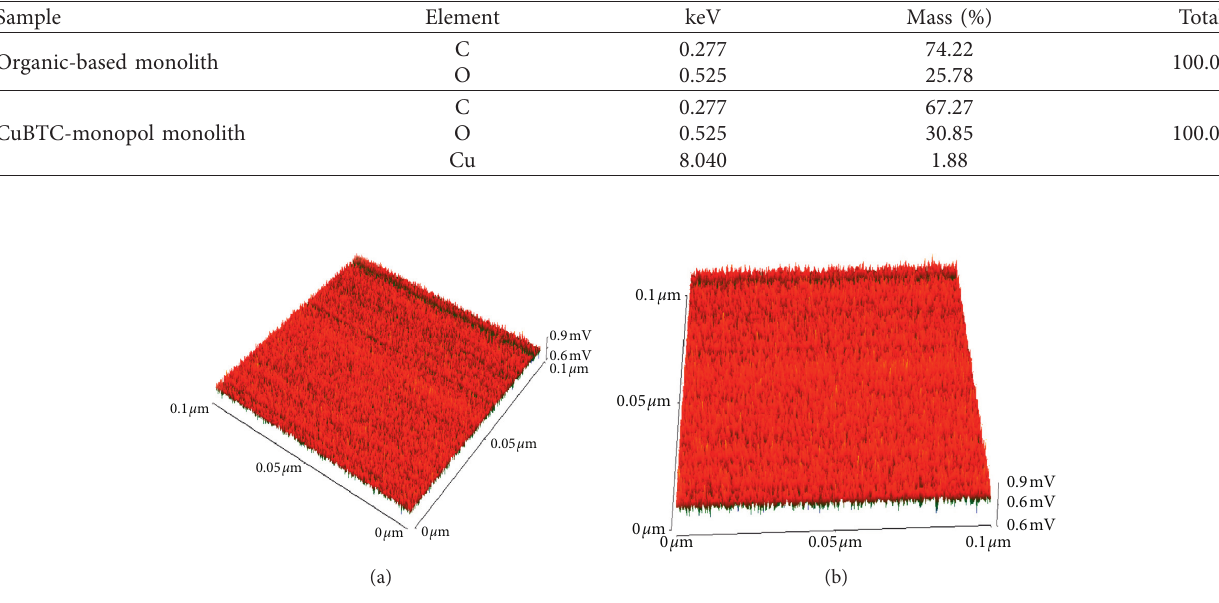
Figure 6: Three-dimensional AFM images recorded for bare organic monolithic material (a) and CuBTC-monopol monolith